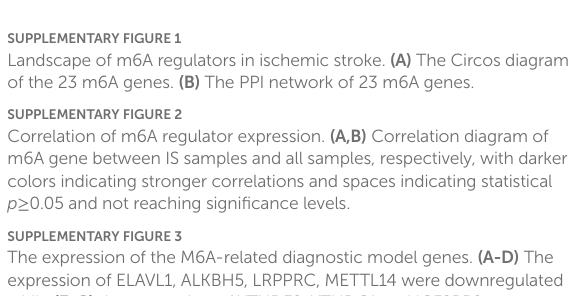
TNFRSF9 between IS and NC groups. (B) Correlation plots show the correlation between the immune-related genes and each of the m6A regulators. The positive correlation between TNFSF4 and IGF2BP3 was higher at 0.77. The negative correlation between IL10 and LRPPRC was high at -0.67. IS, ischemic stroke. NC, normal. ns: value of p ≥ 0.05; *: value of p < 0.05; **: value of p < 0.01; ***: value of p < 0.001; ****: value of p < 0.0001. SUPPLEMENTARY FIGURE 5 The correlation between HLA-related genes and m6A regulators. (A) The boxplot of the HLA-related genes by the Wilcoxon test. There were significant differences in HLA − C, HLA − DOA, HLA − DOB, HLA − DPB1,